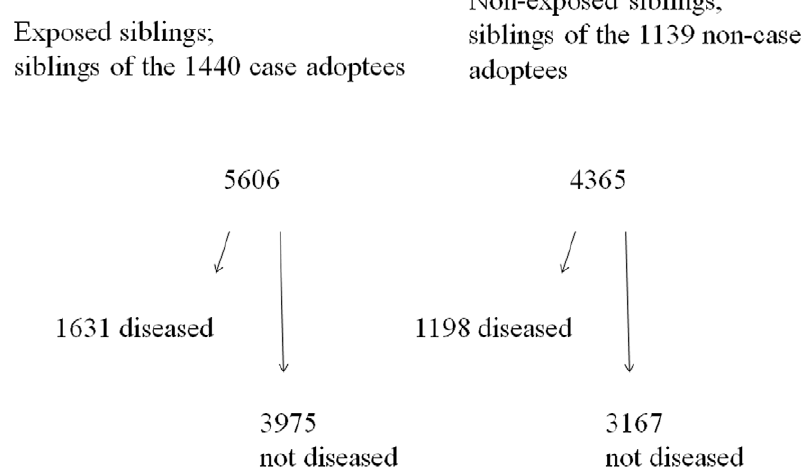
Figure 2. The 9971 siblings in the analyses of incidence.